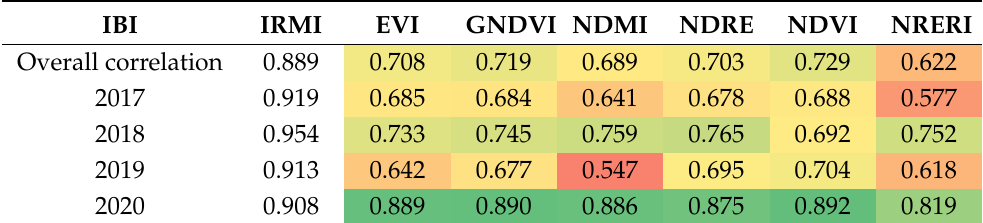
Legend: Red-marked Spearman’s correlation coefficients indicate a significant relationship between IRMI and other vegetation indices. The strength of this relationship is indicated using colors, red color of the cell indicates a weak relationship, orange and yellow indicate a moderate relationship and green indicates a strong relationship. Table 6. Spearman’s rank correlation coefficient for the vegetation index IBI in the individual years and for the whole period (2017–2020).